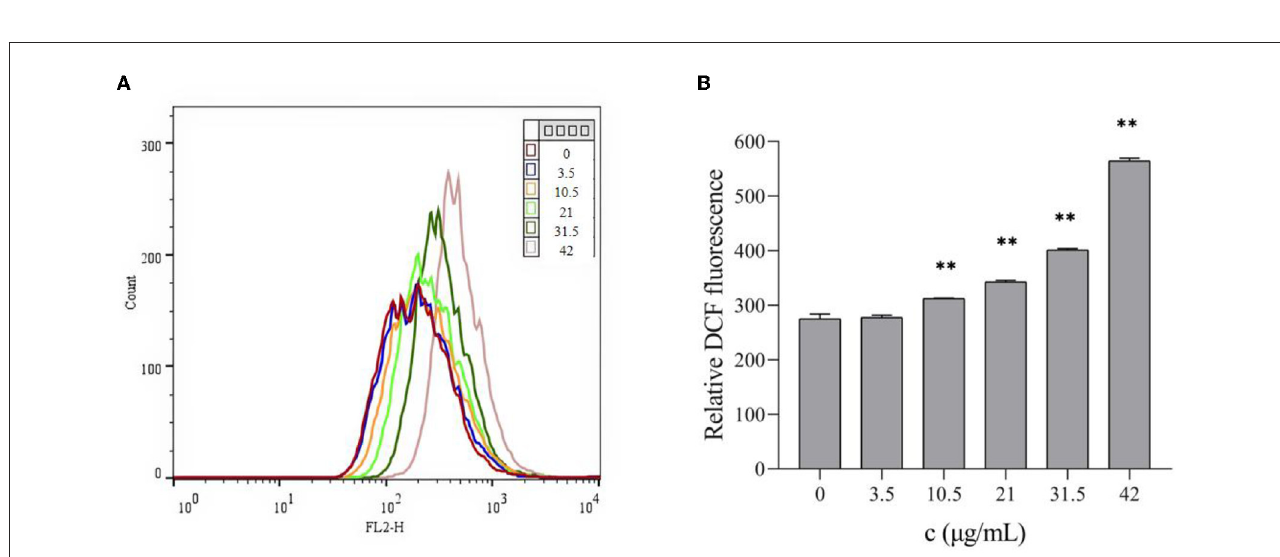
FrontiersinNutrition